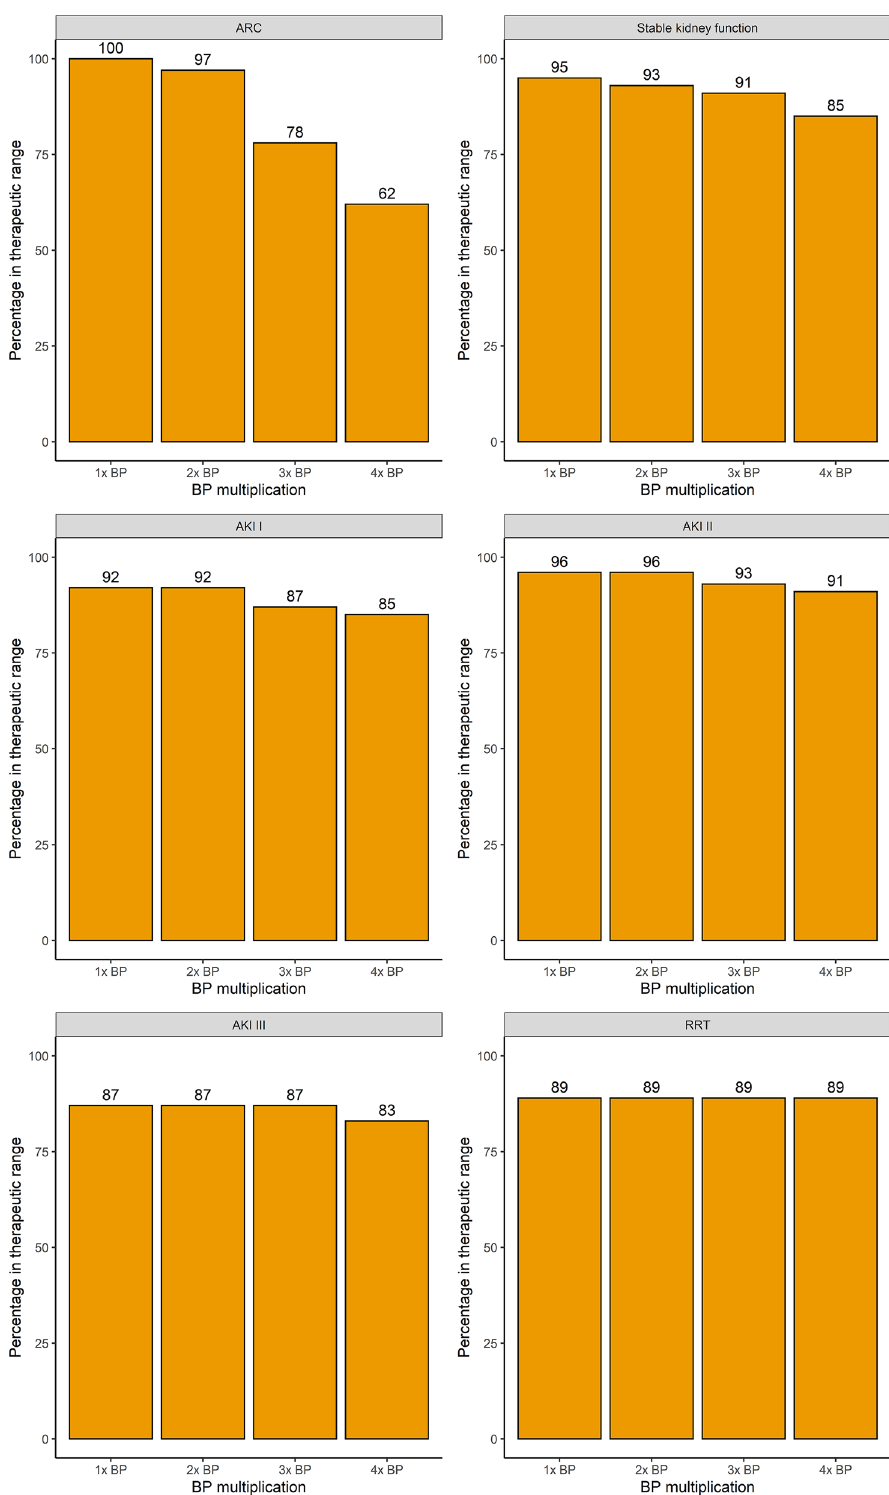
Fig. 10 Percentage of MEM samples within the therapeutic range for different BP multiplications according to renal